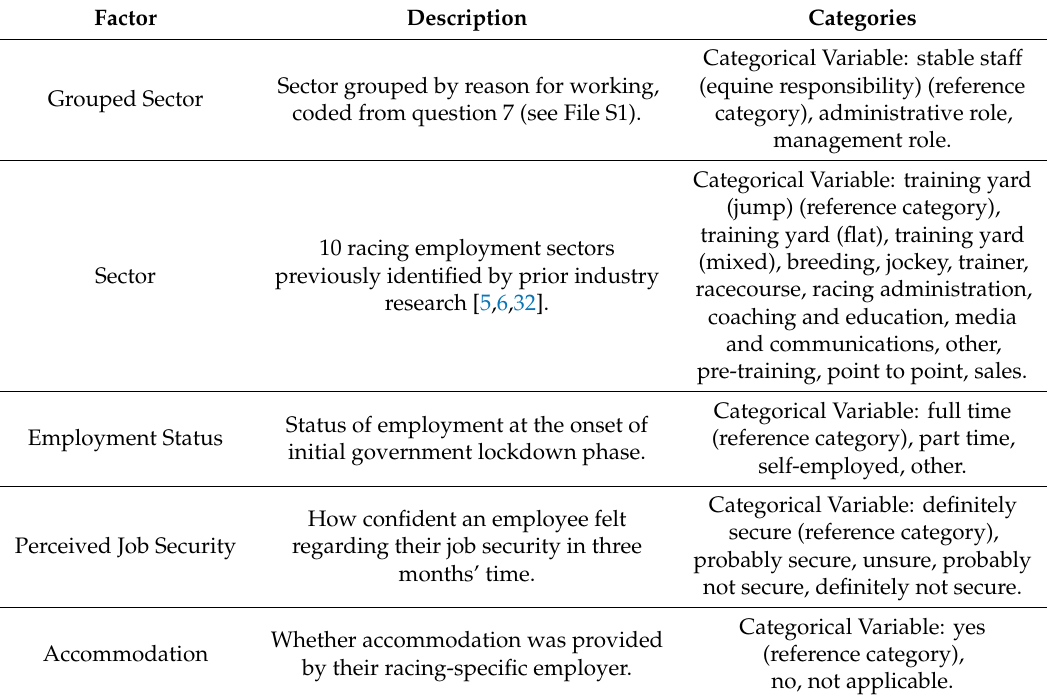
Table 2. Factors included in the univariate